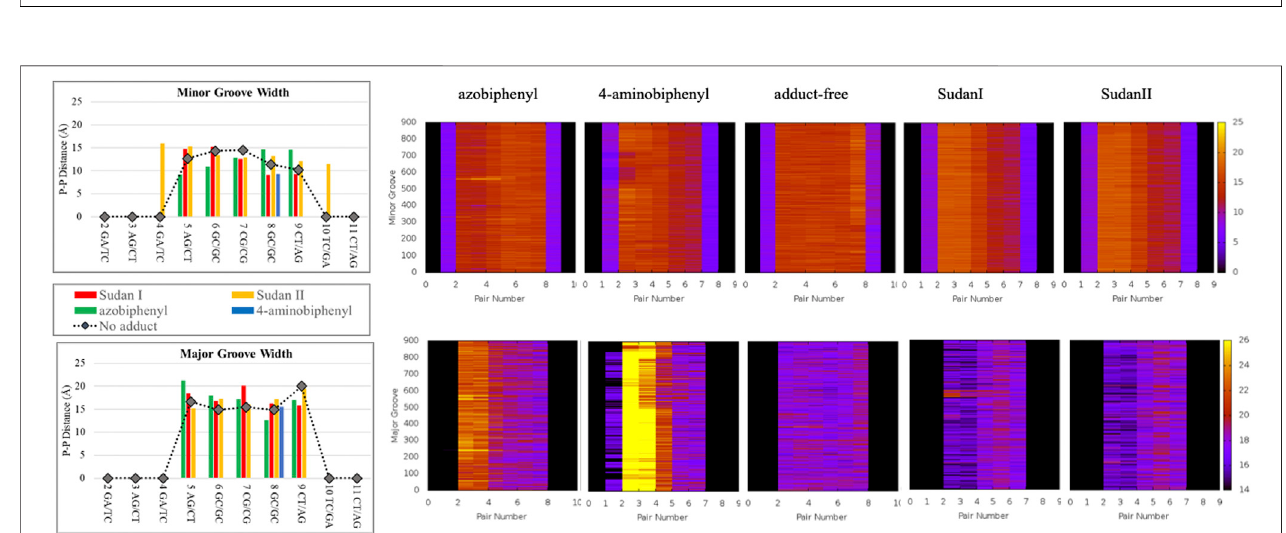
FIGURE4| LengthofvarioushydrogenbondsforunalteredDNAdodecamer(black)andadductswithSudanI(red),SudanII(orange),azobiphenyl(green),and4- aminobiphenyl (blue).